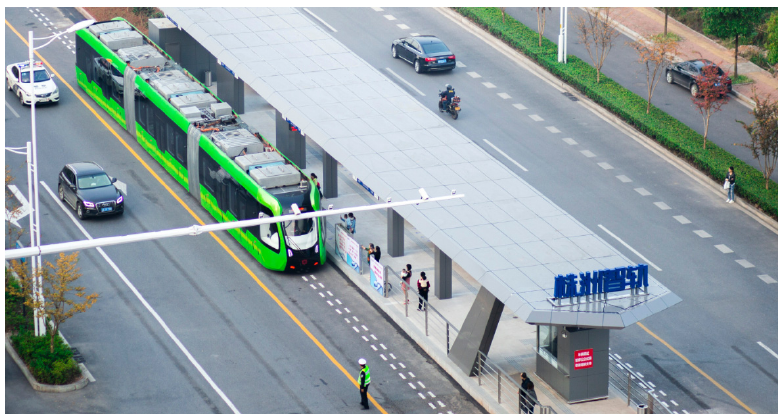
Figure 1. The autonomous rail rapid transit in Zhuzhou, China.